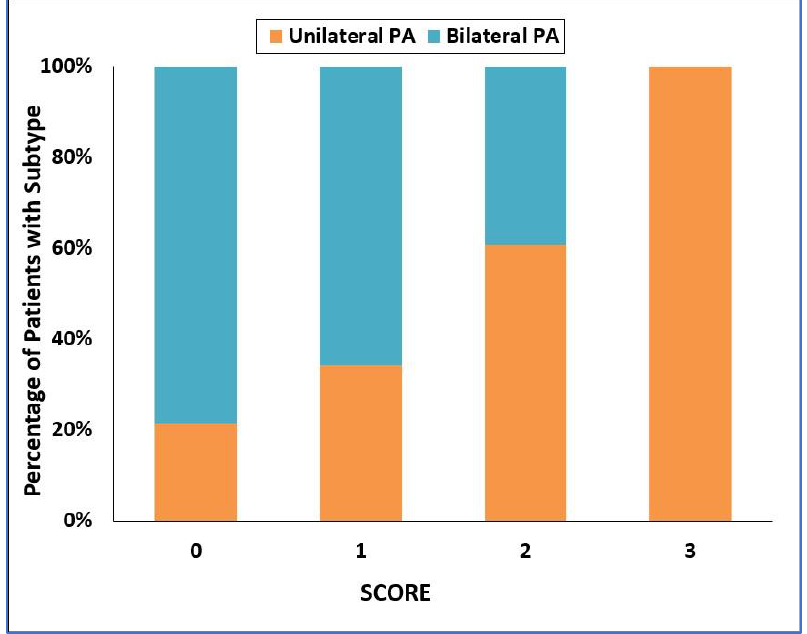
Figure 3. Categorized histogram of the SCORE for unilateral and bilateral primary aldosteronism. PA — primary aldosteronism.